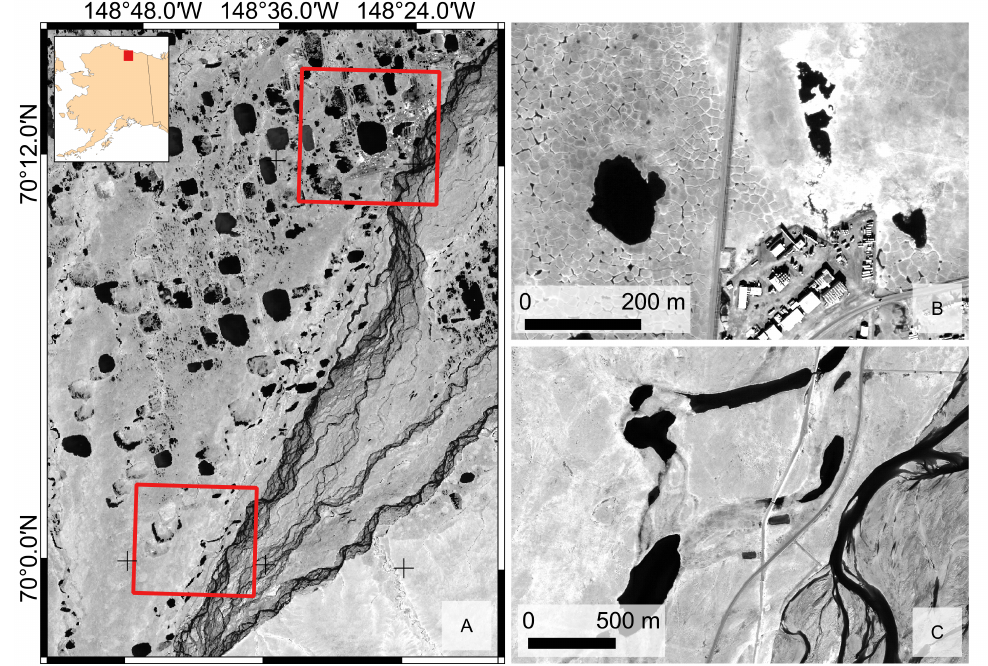
Figure 2. Subfigure ( A ) shows Sentinel-2 near-infrared (NIR) images (Band 8 at 842 nm, acquisition on 23 July 2019) of the study sites (marked with red squares) on the North Slope of Alaska. Detailed area subset with thermokarst lakes near the linear infrastructure in Deadhorse ( B ) and oxbow lakes at mile post 396 of the Dalton Highway ( C ). High-resolution imagery is the pan-sharpened NIR band of Quickbird-2 and WorldView-2, respectively (Copyright: DigitalGlobe, 2006 & 2016).The underlying world border dataset for the inset map of Alaska in ( A ) is available from http://thematicmapping.org/ (accessed on 26 June 2021) and licensed under CC BY-SA 3.0 https://creativecommons.org/licenses/ by-sa/3.0/ (accessed on 26 June